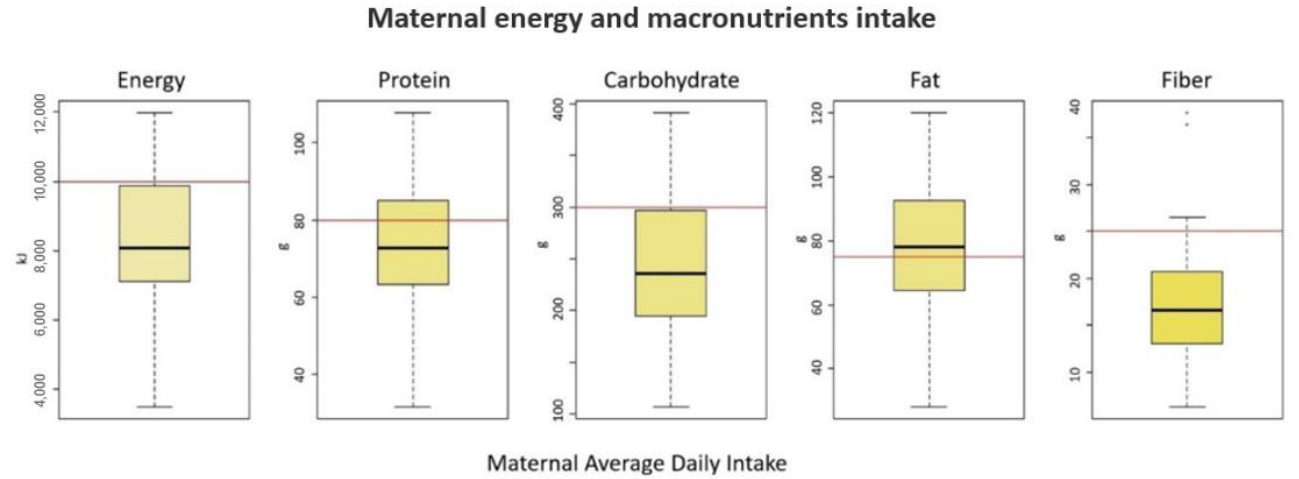
Figure 1. Maternal average daily intake of energy and macronutrients (protein, carbohydrate, fat, and fiber). The red horizontal lines indicate the recommended daily intake.